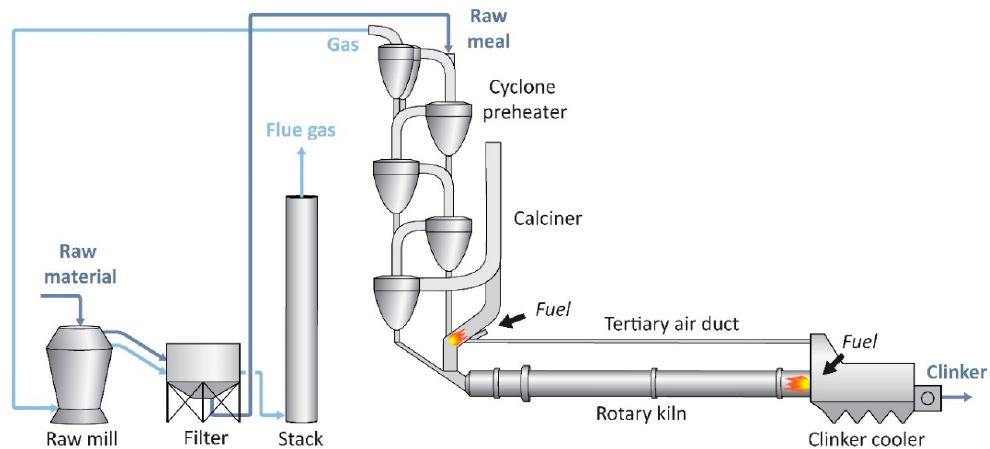
Figure 1 . The clinker burning line of the CEMCAP reference cement plant. Figure 1. The clinker burning line of the CEMCAP reference cement plant.